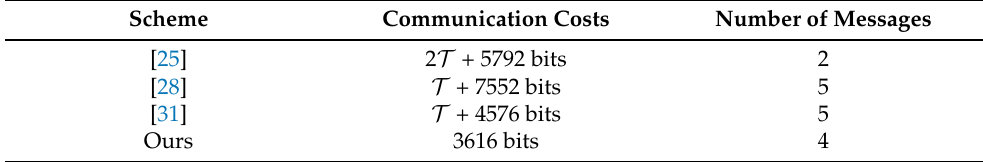
Table 5. Communication Costs